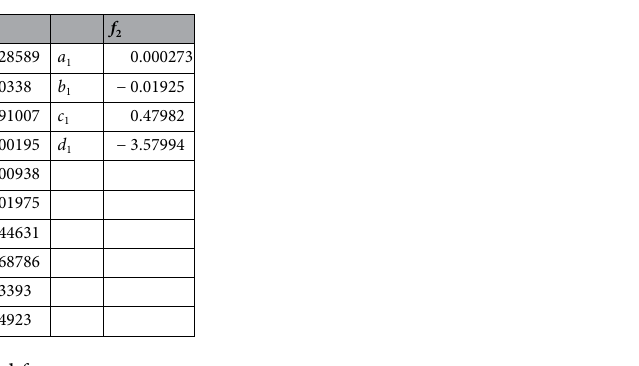
Table 11. Coefficients in f 4 , f 3 , and f 2